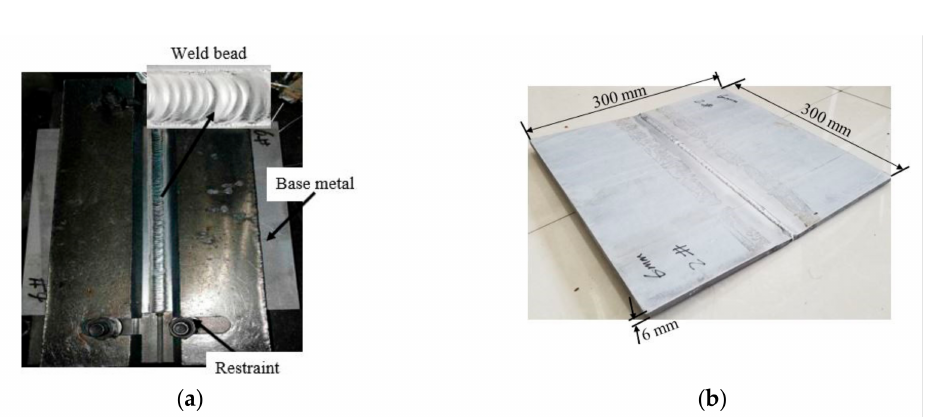
Figure 7. As-weld workpiece ( a ) specimen with restraint ( b ) as-weld Al 2219 plate. Table 3. TIG welding parameters.